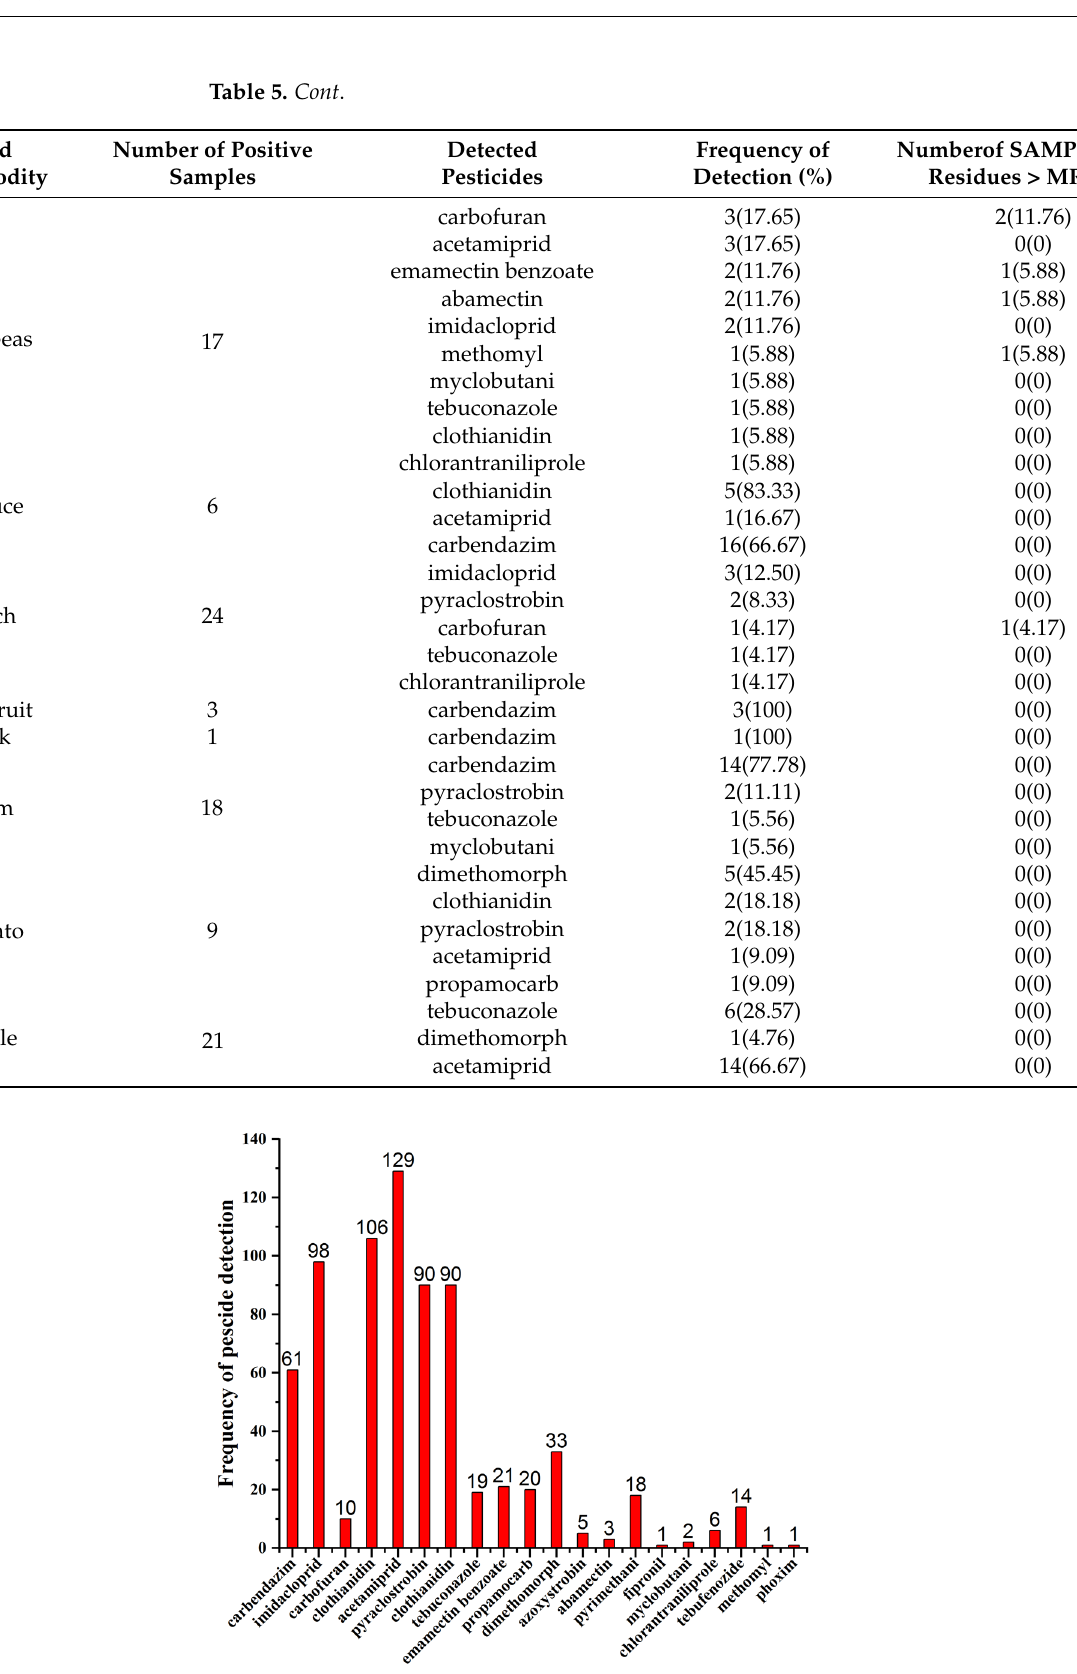
Figure 2. Frequency of the most often detected pesticides in the analyzed samples.